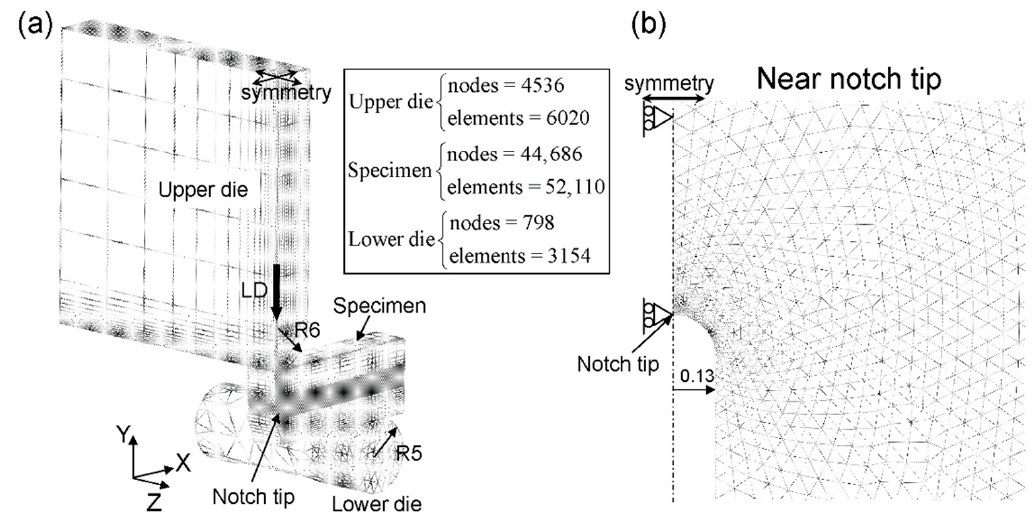
Figure 4. ( a ) Schematic illustration of the three-point bending test simulation and ( b ) the finite element mesh used for the specimen with an initial notch of ρ = 0.13 mm.